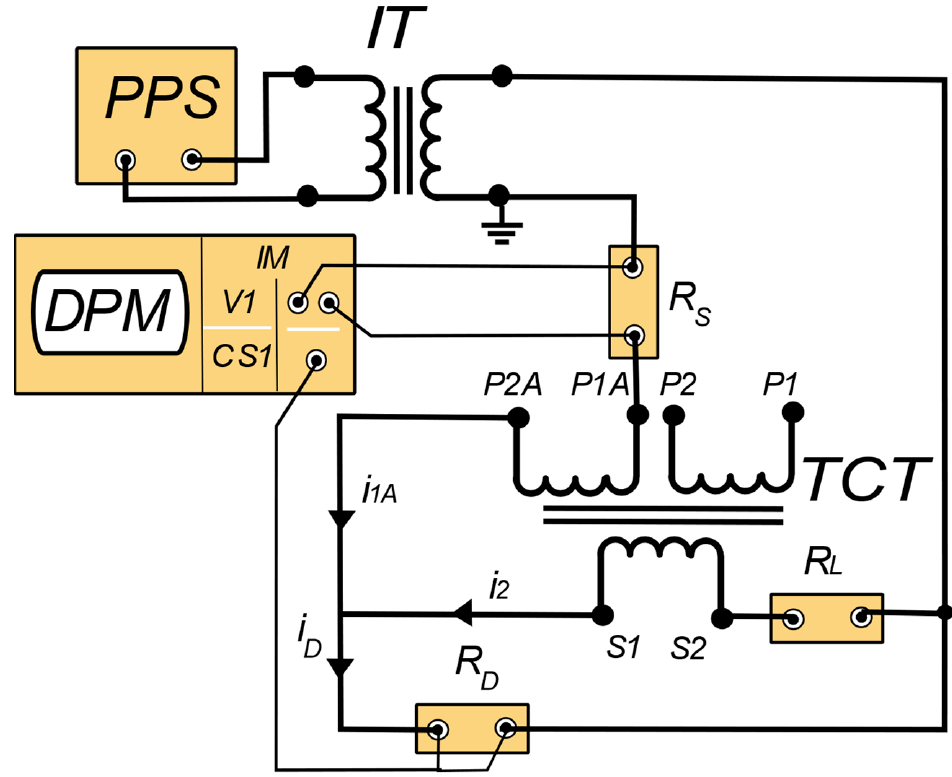
Figure 1. The measuring setup was used to evaluate the wideband accuracy of the tested CTs. In the presented measuring circuit in Figure 1, to determine values of current error and phase displacement specified for a given harmonic, the following input quantities are